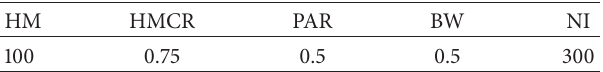
Table 2: HSMA parameter values obtained by the factorial design